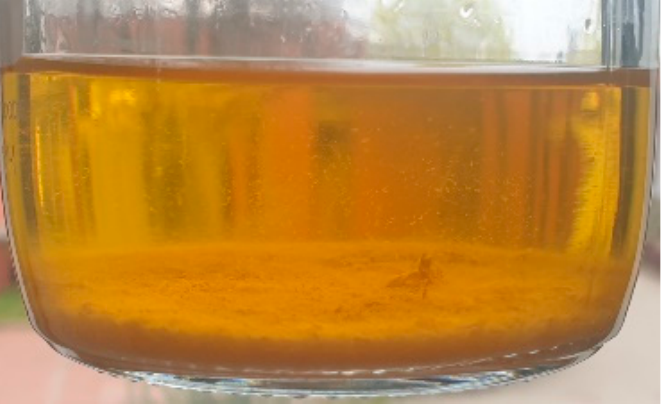
Figure 4. Mizdra after enzymatic hydrolysis.